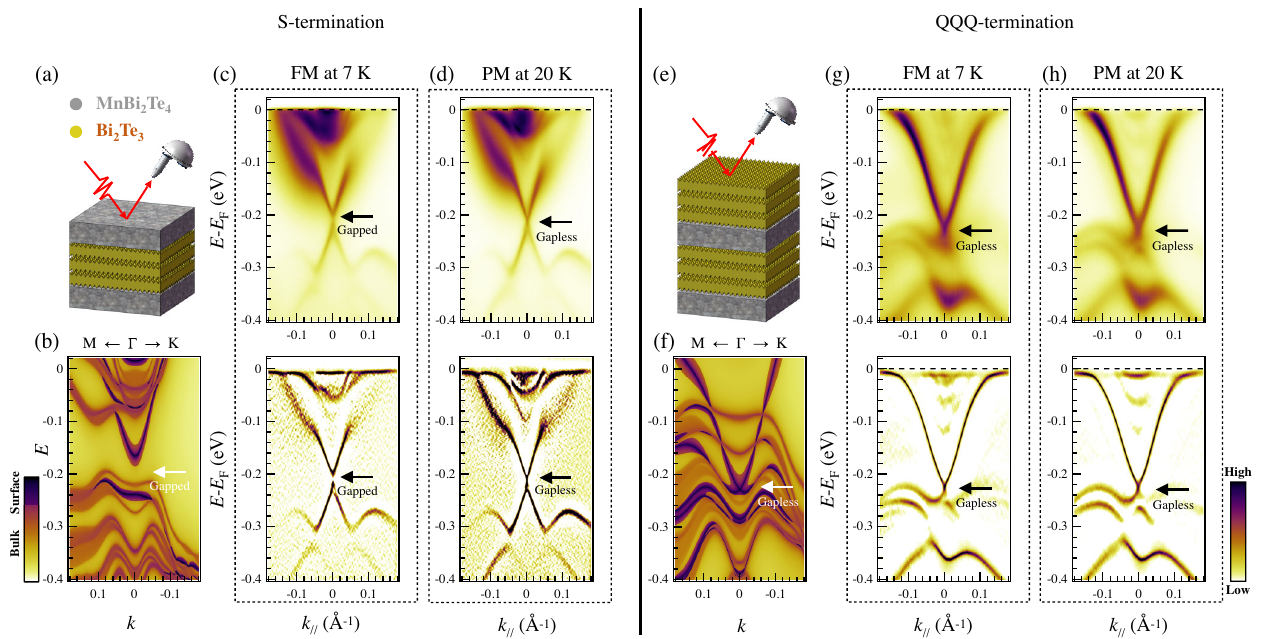
FIG. 2. Temperature evolution of the TSS Dirac cone gap at the S and QQQ termination of MnBi 8 Te 13 . (a) – (d) ARPES results for the S termination. (a) Schematic structural stacking configuration of the S termination. (b) DFT band structure calculated for the FM state, with the surface-only states (dark violet to black) being superposed on the bulk states (yellow, orange, and light violet). (c) Band ¯ M − ¯ Γ − ¯ M ¯ M − ¯ Γ − ¯ M structure along measured at 7 K (FM state). (d) Band structure along measured at 20 K (PM state). Data in panels (c) and (d) are shown in the form of the ARPES original spectra (top panel) and the 2D curvature spectra [46] (bottom panel). (e) – (h) Same as panels (a) – (d) but for the QQQ termination. Clearly, entering the FM state opens a gap at the TSS Dirac cone for the S termination, while no such gap is observed for the QQQ